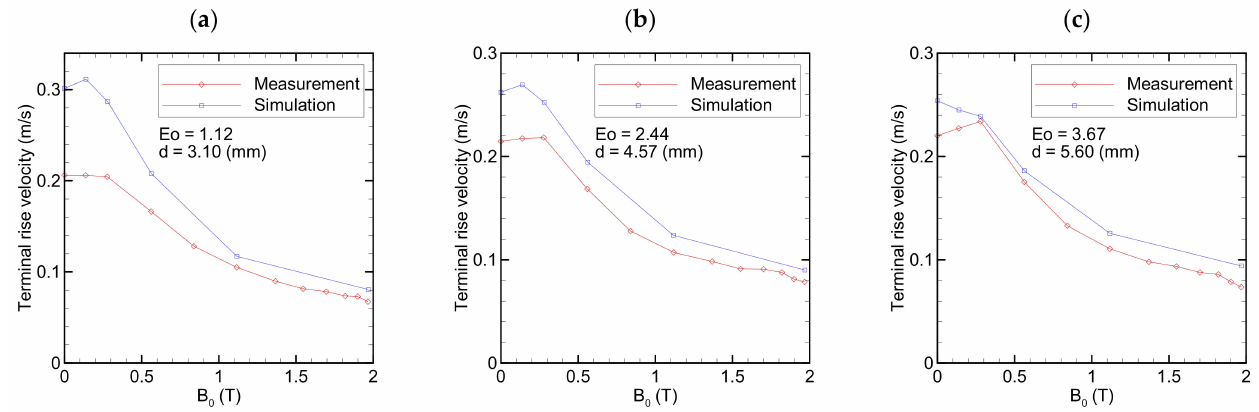
Figure 12. Comparison of terminal rise velocities as functions of B 0 for d = 3.10 mm ( a ), 4.57 mm ( b ) and 5.60 mm ( c